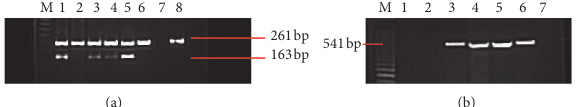
Figure 3: Agarose gel profiles displaying the PCR products of Beijing multiplex PCR and conventional PCR. (a) Agarose gel profile displaying the PCR products of Beijing multiplex PCR (M; 50bp DNA marker; lanes 1, Beijing lineage positive control (a confirmed Beijing strain); 2–6, amplicons from culture isolates; 7, negative control (water); 8, non-Beijing control (the standard Mycobacterium tuberculosis strain H37Rv)). (b) Agarose gel profile displaying the PCR products of Beijing multiplex PCR and conventional PCR for the two culture- positive isolates in which the Beijing/non-Beijing status could not be ascertained (M; 50bp DNA ladder; lanes 1, Beijing multiplex PCR product of culture isolate (a); 2, Beijing multiplex PCR product of culture isolate (b); 3 and 4, positive controls (the standard Mycobacterium tuberculosis strain H37Rv); 5, conventional PCR product of culture isolate (a); 6, conventional PCR product of culture isolate (b); 7, negative control (water)).